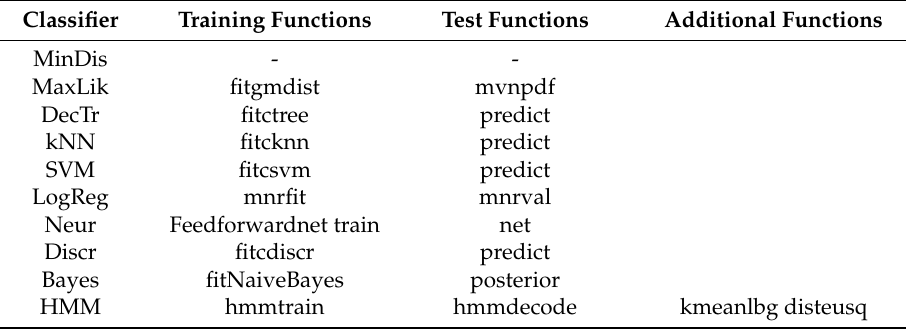
Table 2. MATLAB functions supporting the various classifiers.